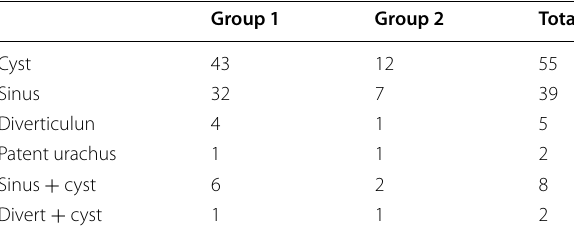
Table 2 Different kinds founded of urachal remnants Group